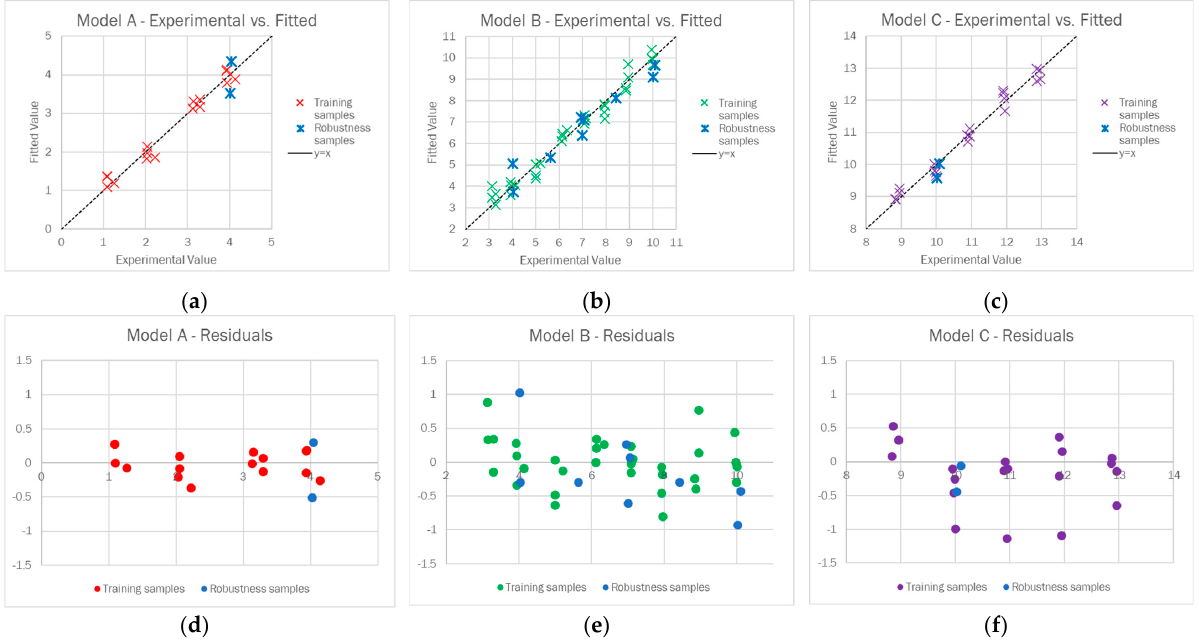
Figure 6. Experimental vs. fitted plot for the training (red for model A, green for model B, violet for model C) and robustness samples (blue) for model A ( a ), model B ( b ), and model C ( c ), and the residuals for training (red for model A, green for model B, violet for model C) and the robustness samples (blue) for model A ( d ), model B ( e ), and model C ( f